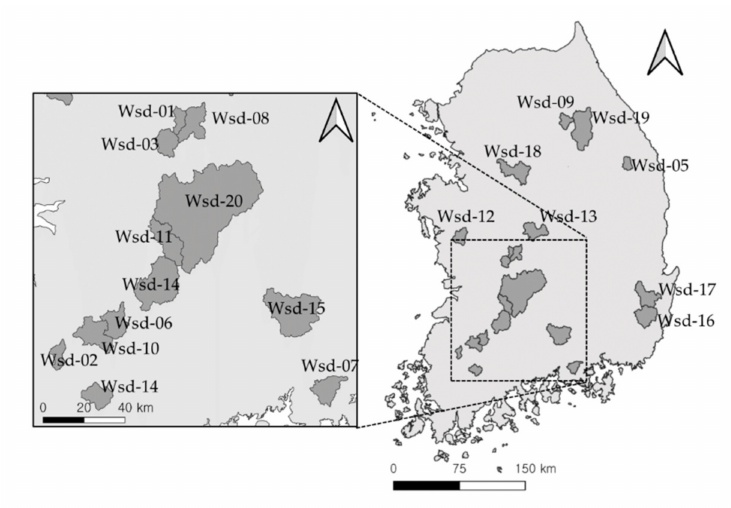
Figure 1. Location of study watershed. Table 1. Land uses in the study